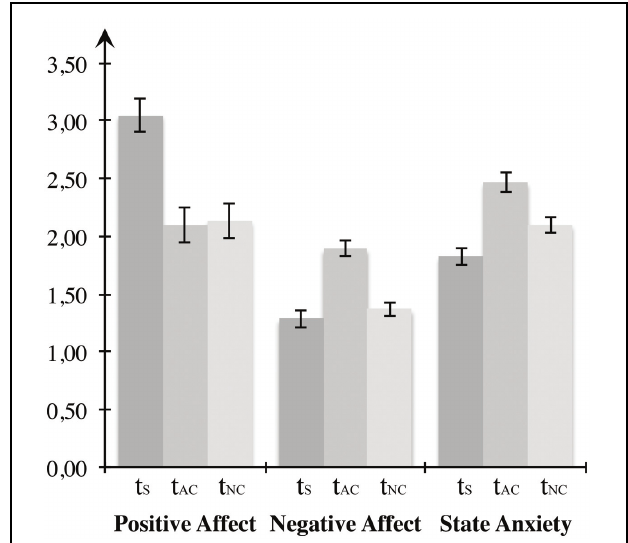
FIGURE 3 | Mood induction for Experiment 1. The first two bar groups form the PANAS scores for positive and negative affect, the last bar group represents the STAI score for state of fear. All three states were measured before the first block, between the first and second block, as well as following the end of the last block. When conducting the experiment, presentation of the blocks was counterbalanced across participants, whereas here, t S depicts the first measurement, t AC the measurement after the affective block, and t NC the measurement after the neutral block. Error bars depict ± 1